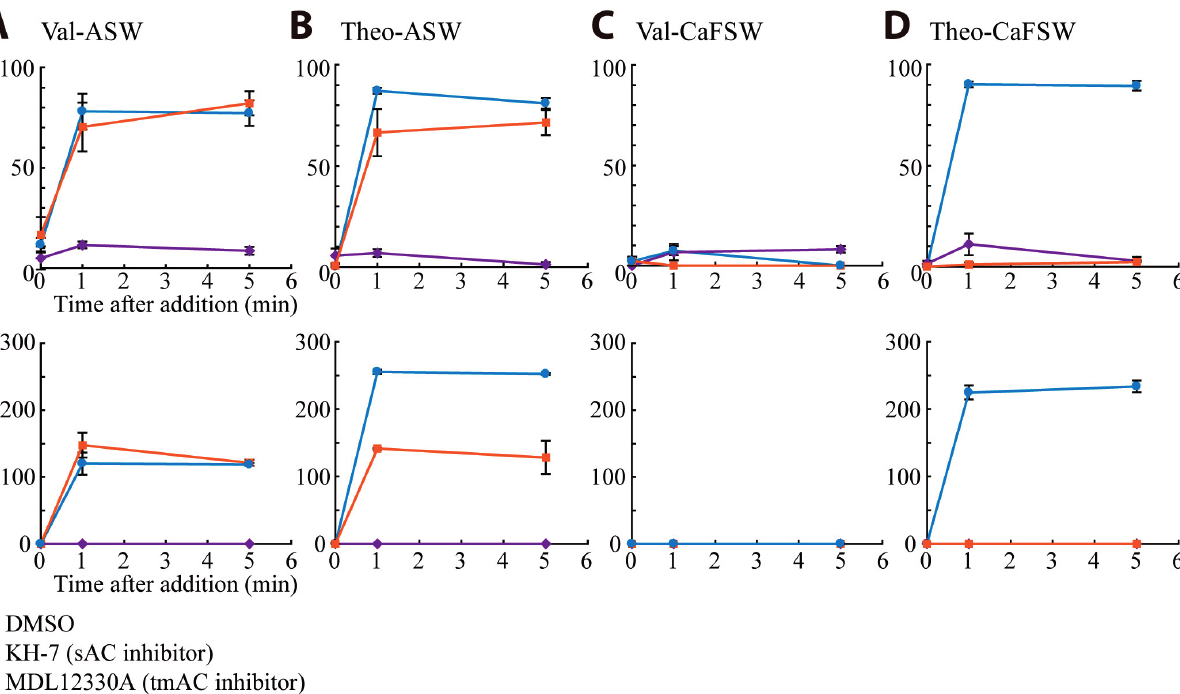
Figure 4. Effects of AC inhibitors on valinomycin (Val)- or theophylline (Theo)-induced activation of Ciona sperm motility. The percentage of motile sperm and curvilinear velocity were measured before, 1 and 5 min after the addition of 10 nM valinomycin or 1 mM theophylline in artificial sea water (ASW; A , B ) or Ca 2+ -free sea water (CaFSW; C , D ). Sperm were treated with 0.5% DMSO (control), 100 μ M MDL12330A or 10 μ M KH-7 respectively for 3 min before the addition of valinomycin or theophylline. Values